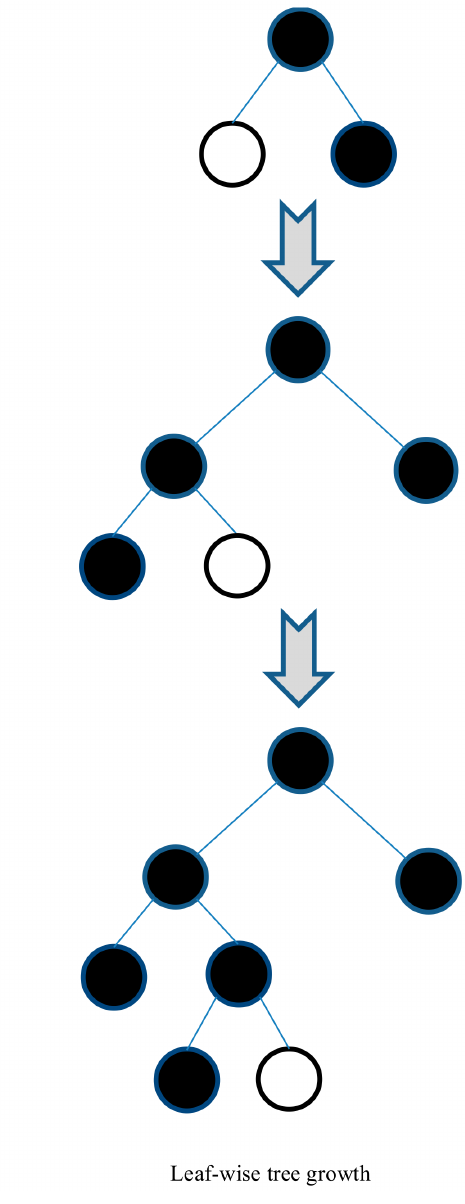
Figure 2. Comparison of level-wise tree growth and leaf-wise tree